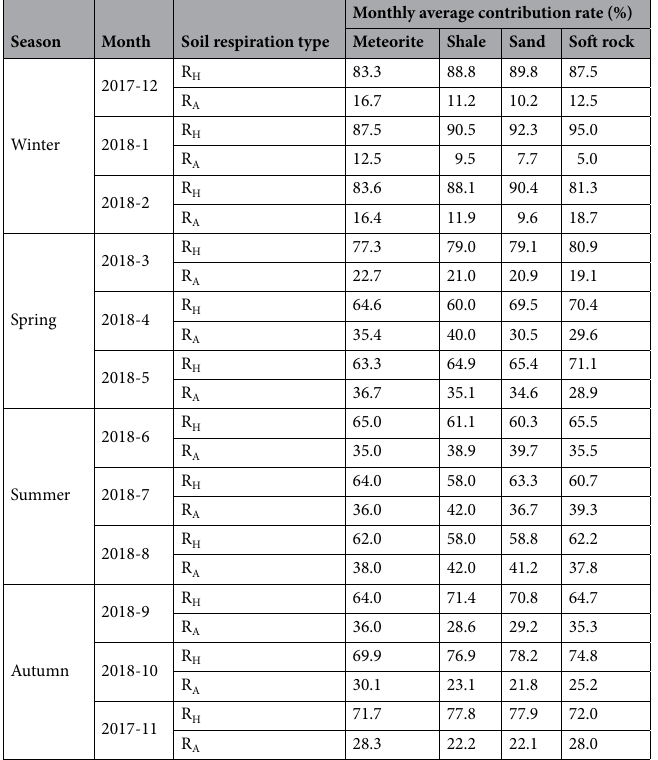
Table 5. Monthly average contribution of soil respiration components to total respiration for different reconstituted soils. R H heterotrophic respiration, R A autotrophic